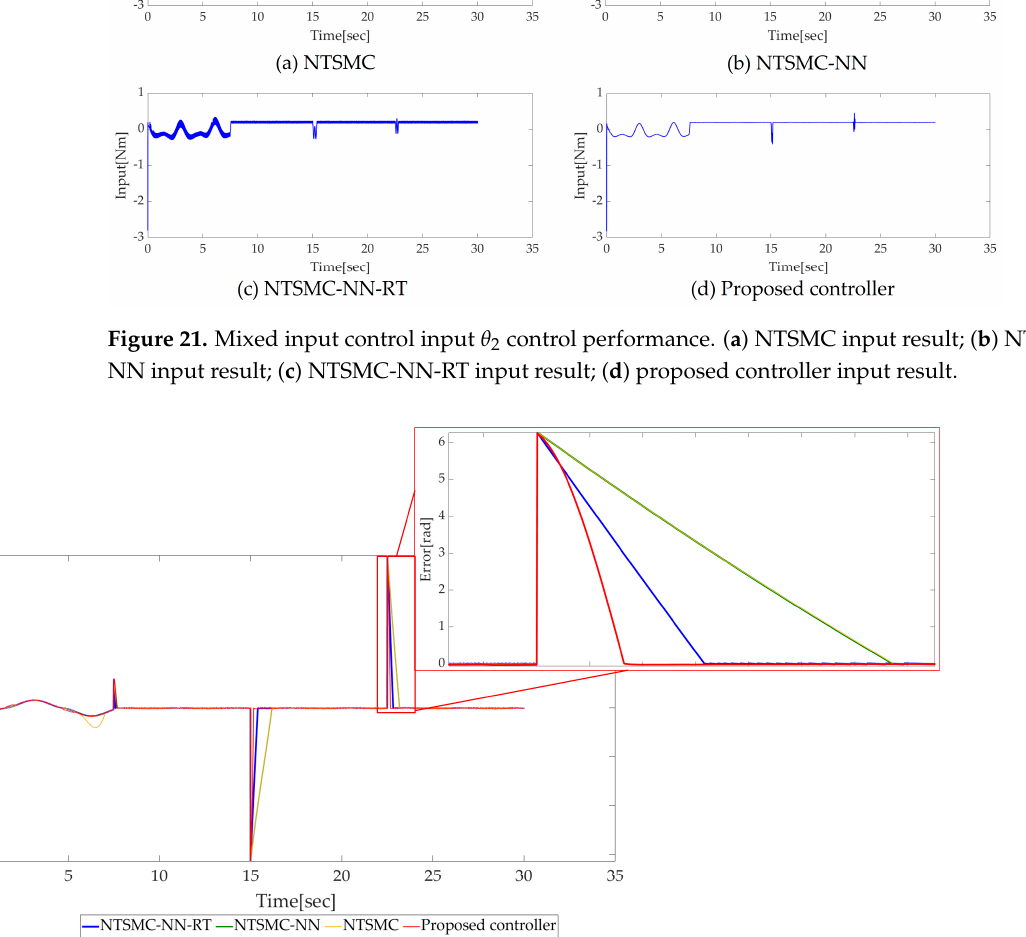
Figure 21. Mixed input control input 𝜃 (cid:2870) control performance. ( a ) NTSMC input result; ( b ) NTSMC-